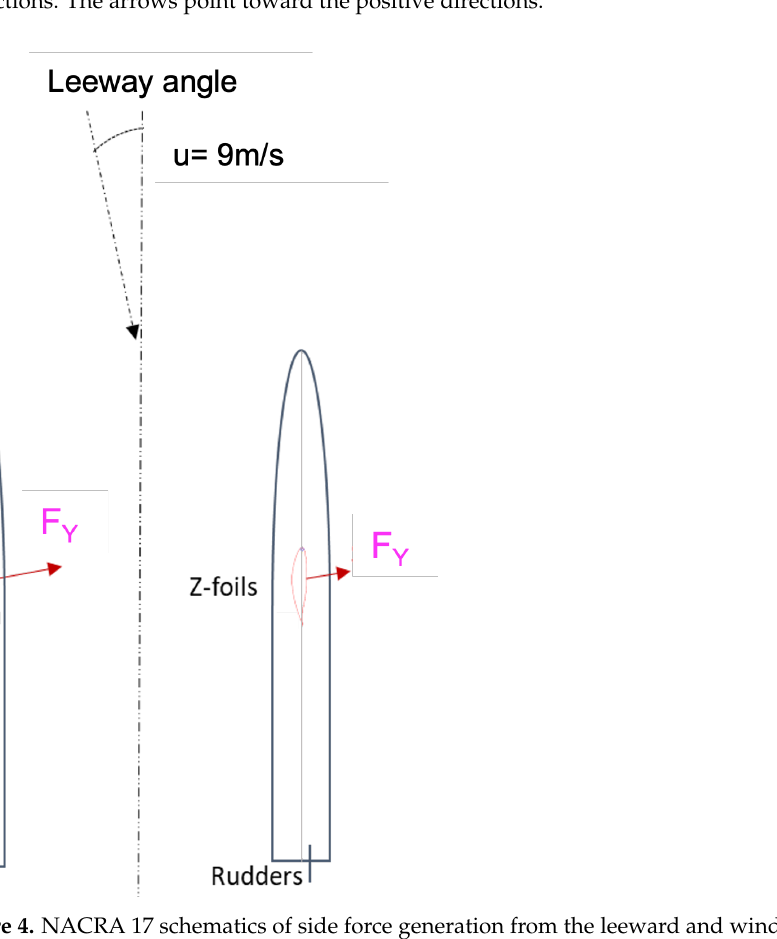
Figure 3. Reference systems for the investigated forces, leeway and rake angles, and measured deflections. The arrows point toward the positive directions.